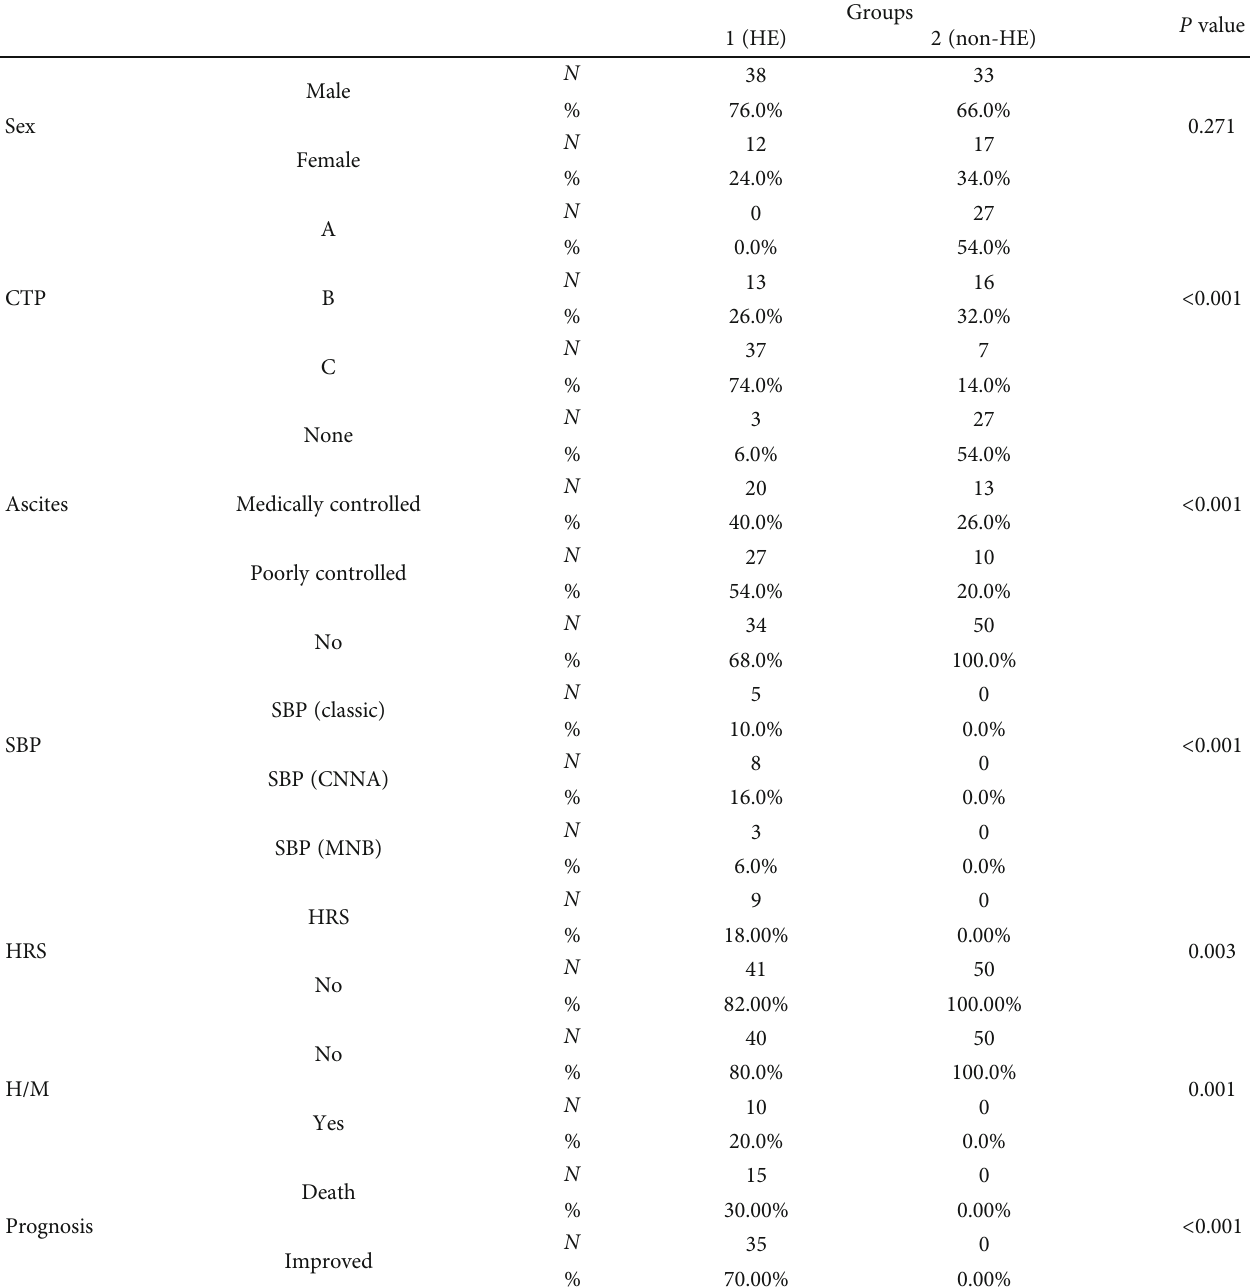
Table 2: Other characteristics in both